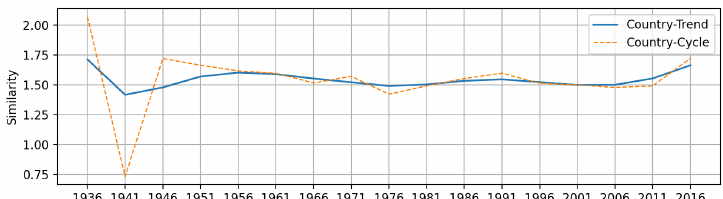
Figure 7. The cycle term of HP filter.